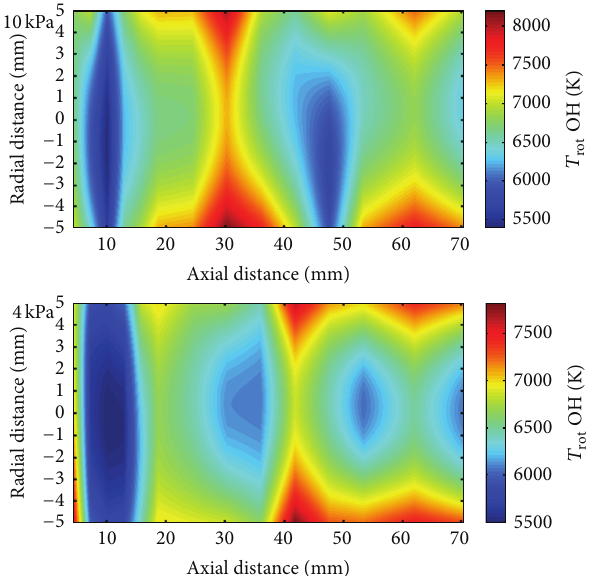
Figure 5: Rotational temperature distribution in the jet for chamber pressures 10kPa and 4